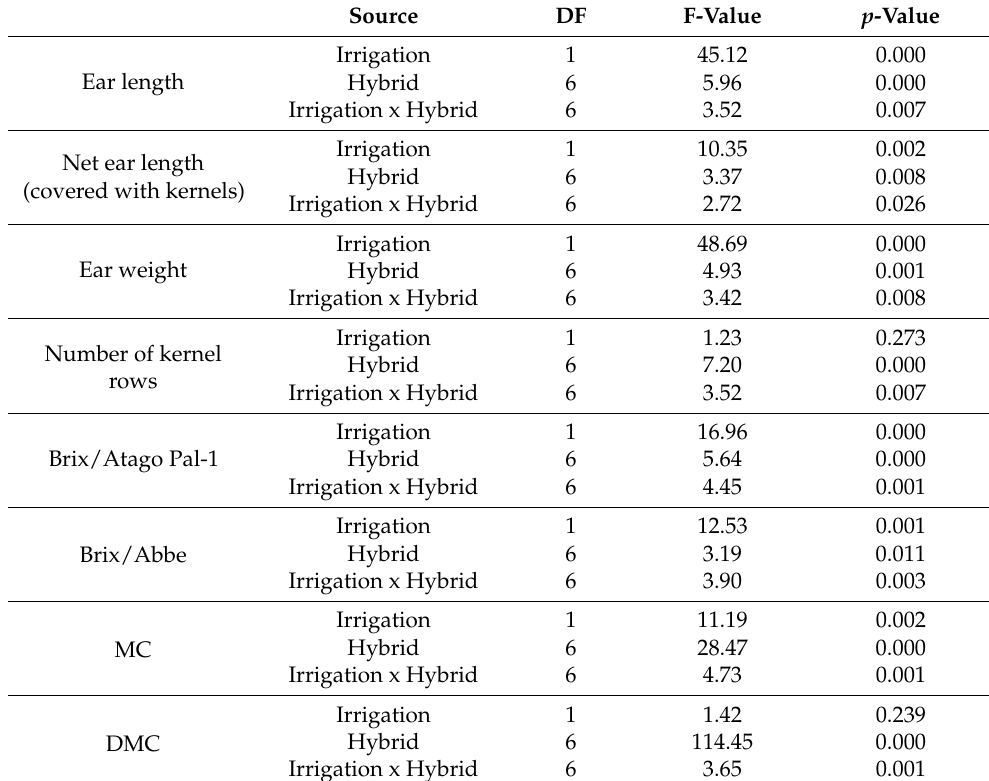
Table 2. Variance analysis on parameters in different irrigation schemes with different maize hybrids.